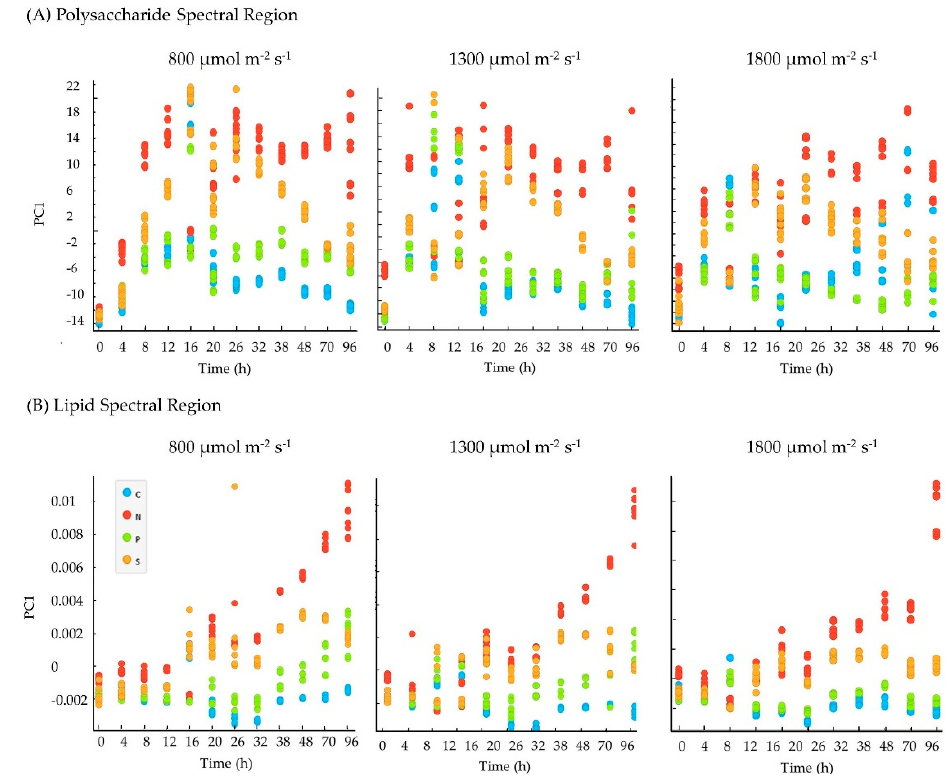
Figure 3. FTIR-HTS spectra PCA score plots of ( A ) polysaccharide (1200–900 cm − 1 ) and ( B ) lipid (3000–2800 cm − 1 and 1800–1700 cm − 1 ) regions of C. vulgaris biomass grown on different nutrient conditions (blue for control, red for nitrogen starvation, green for phosphorus starvation and orange for sulphur starvation) and under three light intensities in experiment 1.